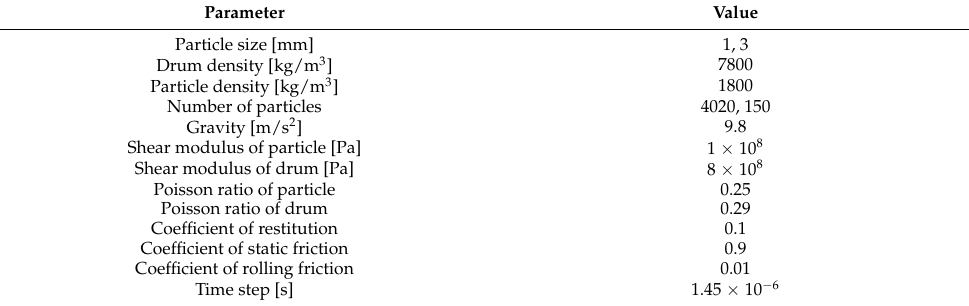
Table 1. Simulation